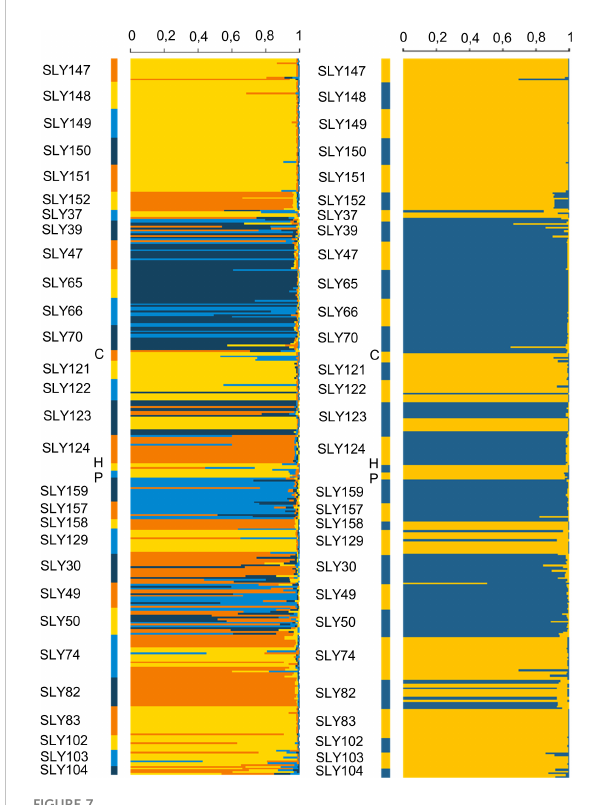
FIGURE 7 Classi fi cation of individuals using Structure 2.3.4 in two clusters ( K = 2, left) and four clusters ( K = 4, right).